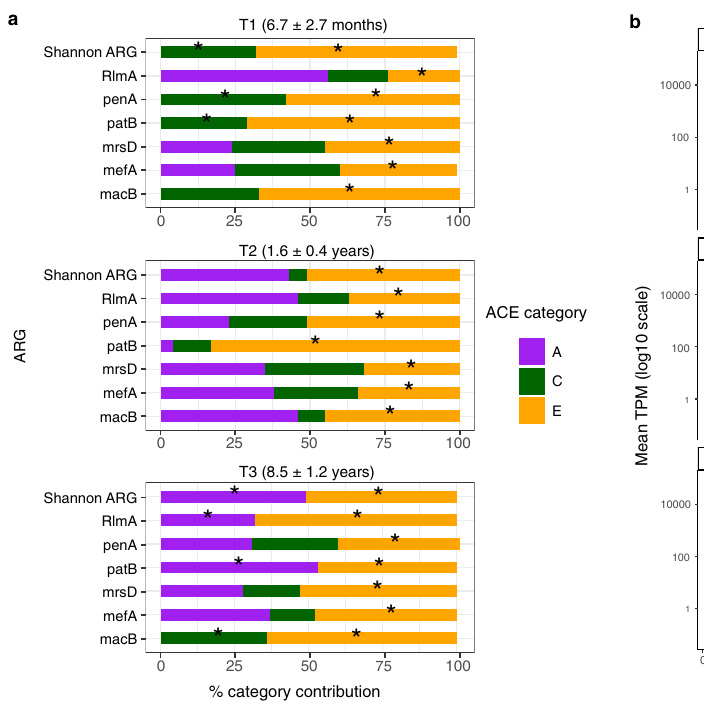
Fig. 6 | Host-genetic and environmental in fl uences on the resistome. a Stacked bar chart shows standardised estimates of genetic effect/heritability (A), shared environmentaleffect(C),andindividualenvironmentaleffects(E)pertimepointas percentages for composition metrics at a global ( α -diversity) and speci fi c ARG level. Estimates of A, C, and E were determined from a formal heritability analysis, using a variance components model approach for a quantitative trait, under the assumptions of the classic twin design. Black stars indicate signi fi cance ( p <0.05,